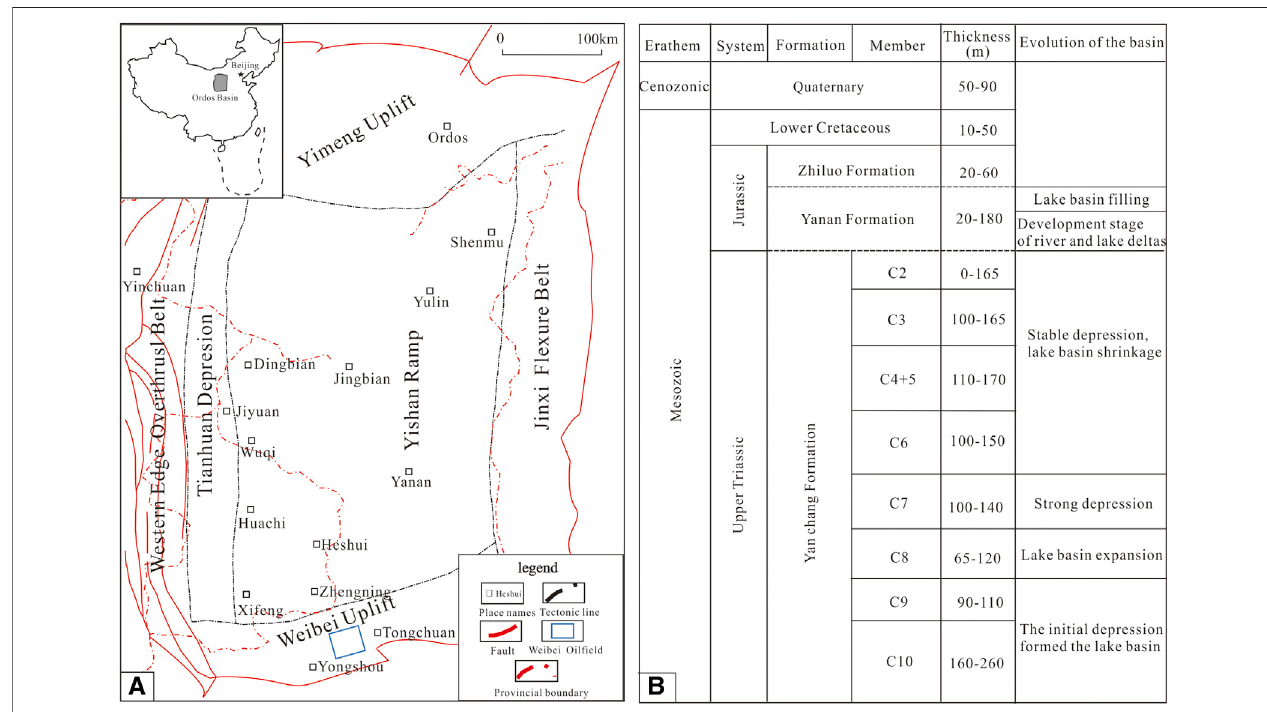
FIGURE 1 | Location of the Weibei Oil fi eld (A) and stratigraphic column of the Yanchang Formation in the Ordos Basin (B) (modi fi ed from Wang et al., 2022).